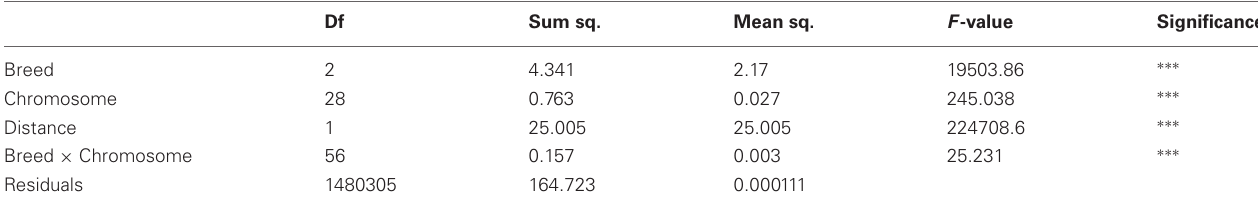
Table 2 | Effects of distance, breed, BTA on measured LD. Df Sum sq. Mean sq.